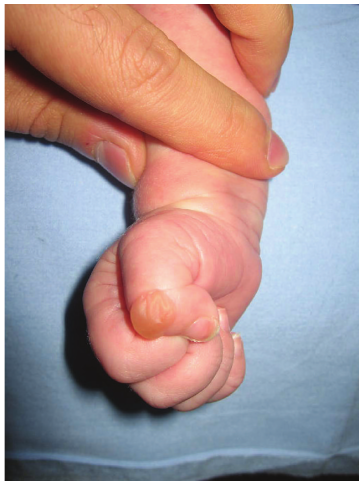
Figure 2: Blistering of the skin on the hand.